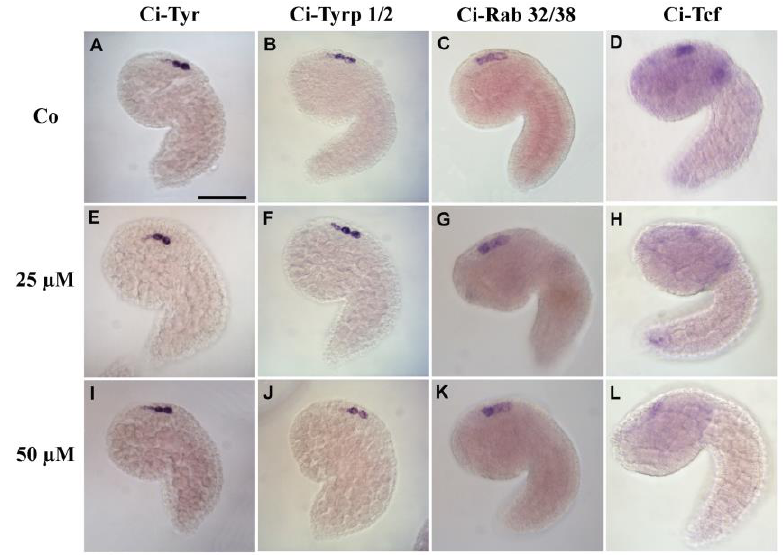
Figure 4. Effects of WAY-100635 treatment on genes involved in pigment cell formation. Expression patterns of Ci-Tyr , Ci-Trp 1/2 , Ci-Rab 32/38, and Ci-Tcf in control (Co) ( A – D ) and embryos